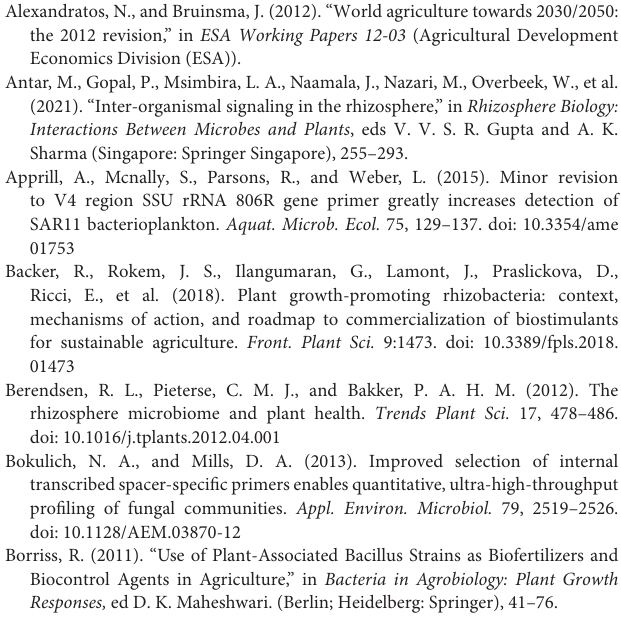
Supplemental Table 4 | Variance explained by each principal coordinates from Figure 5 ’s